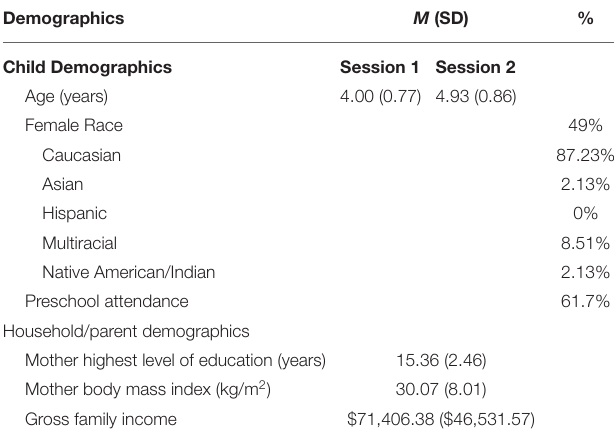
TABLE 1 | Demographic